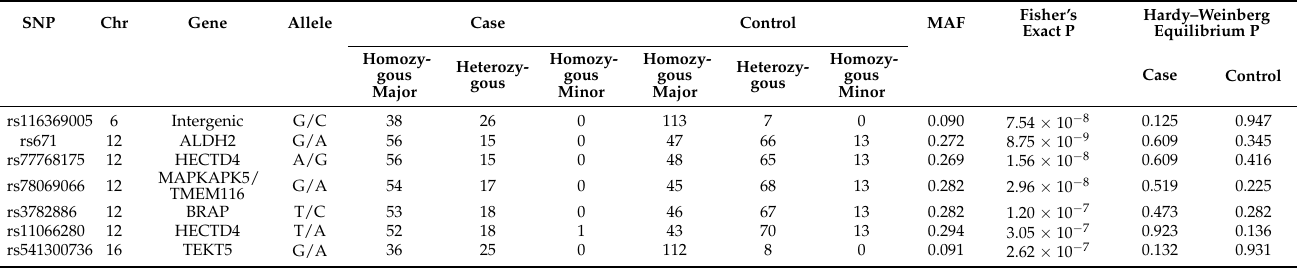
Table 2. Leading variants associated with alcohol consumption levels in this